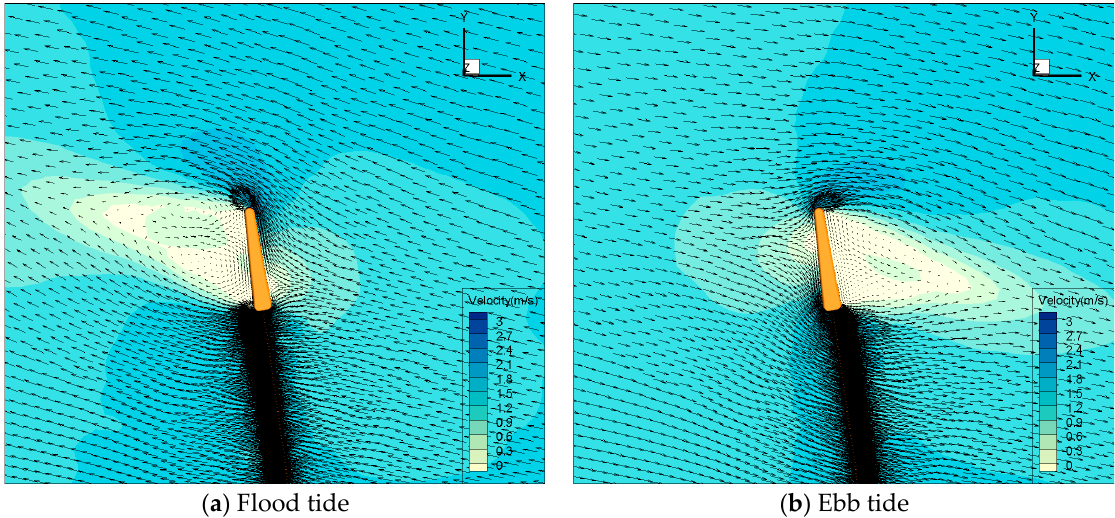
Figure 10. Simulated current fields near the Southern man-made Island.